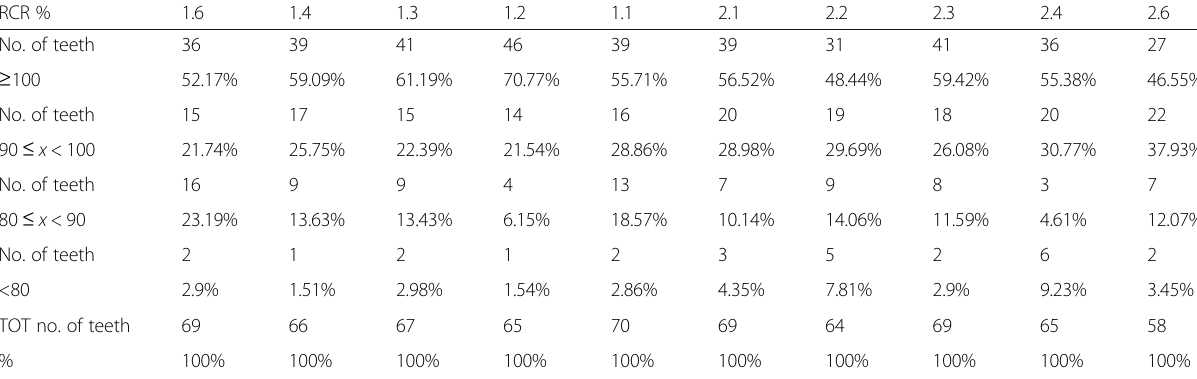
Table 3 Number and percentage of the upper teeth presenting rRCR = 100% (no RR), rRCR between 90 and 100 (slight RR), rRCR between 80 and 90 (moderate RR), and rRCR = 80 (severe RR) RCR %